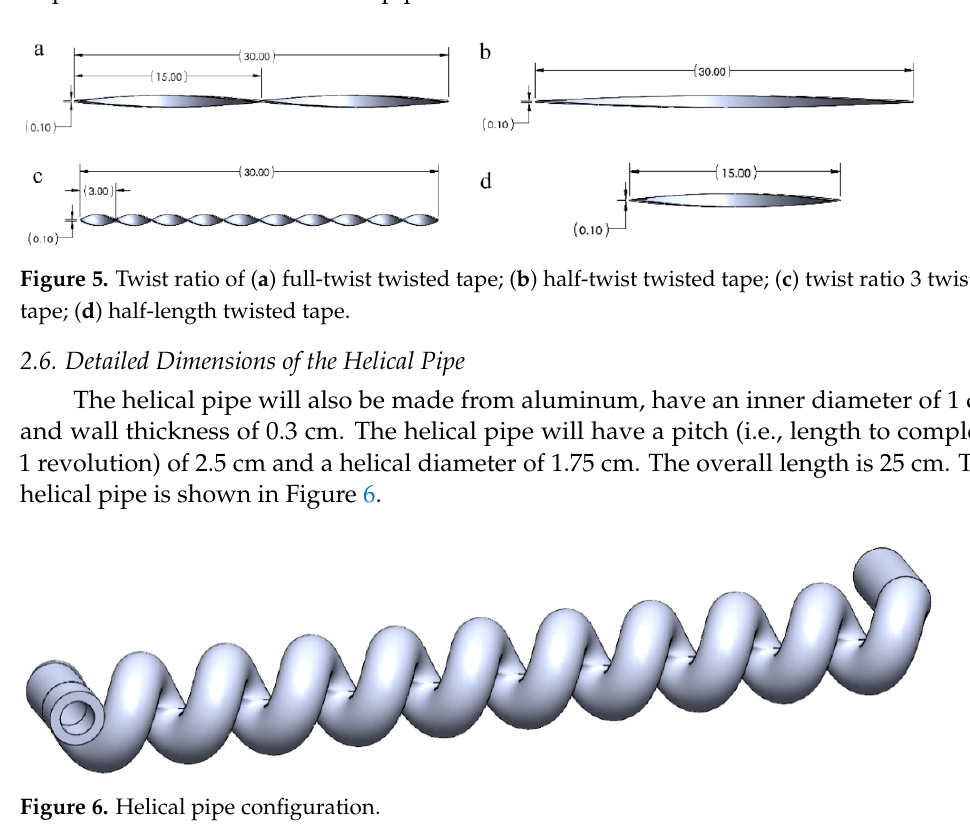
Figure 4. Finite element analysis.